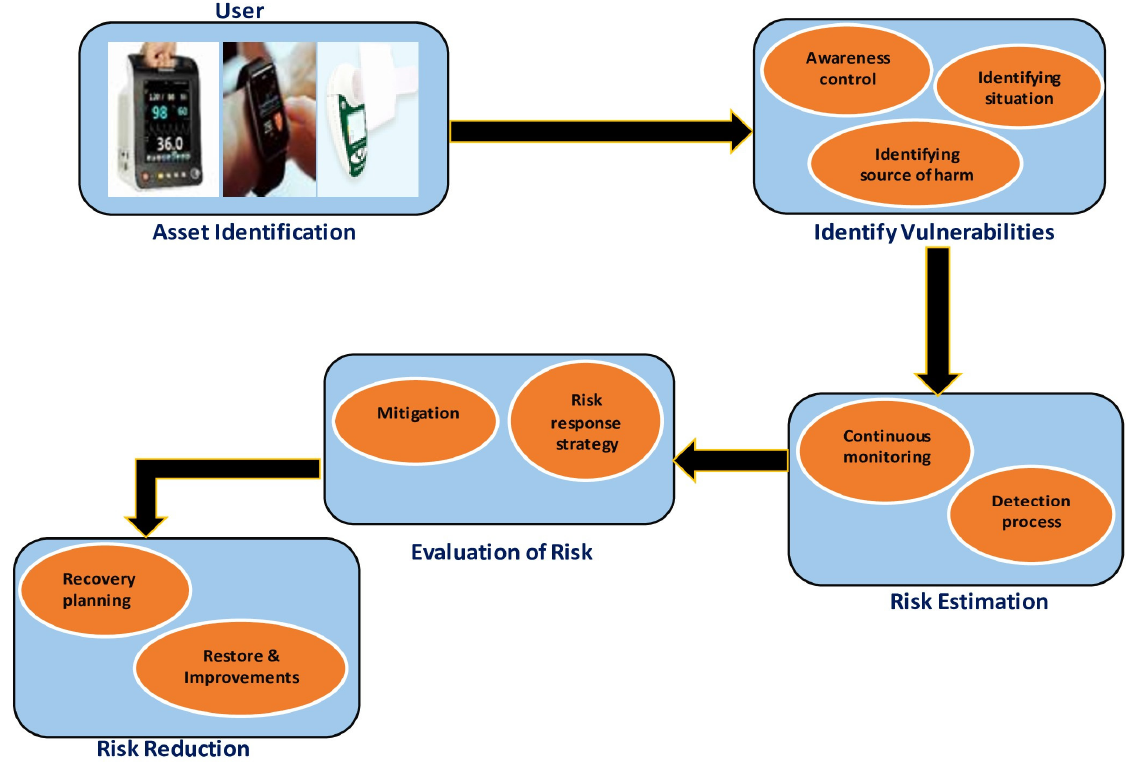
Figure 18. Proposed framework . Figure 18. Risk assessment